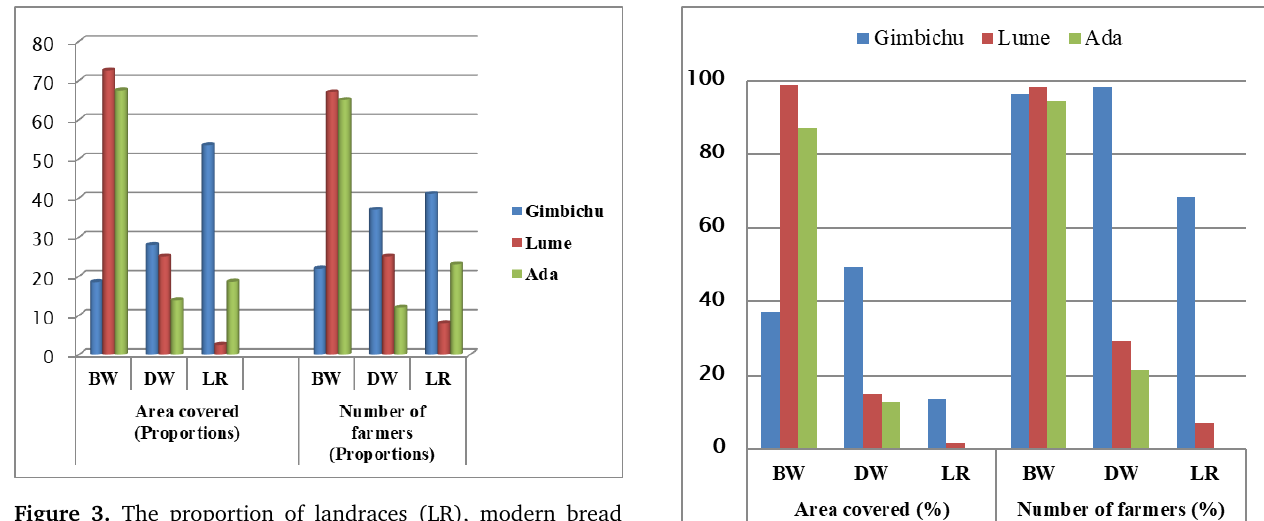
Figure 3. The proportion of landraces (LR), modern bread wheat (BW) and durum wheat (DW) varieties by area coverage and number of farmers in three Ethiopian districts in 2017 based on direct field observations on 56 farms in the districts.